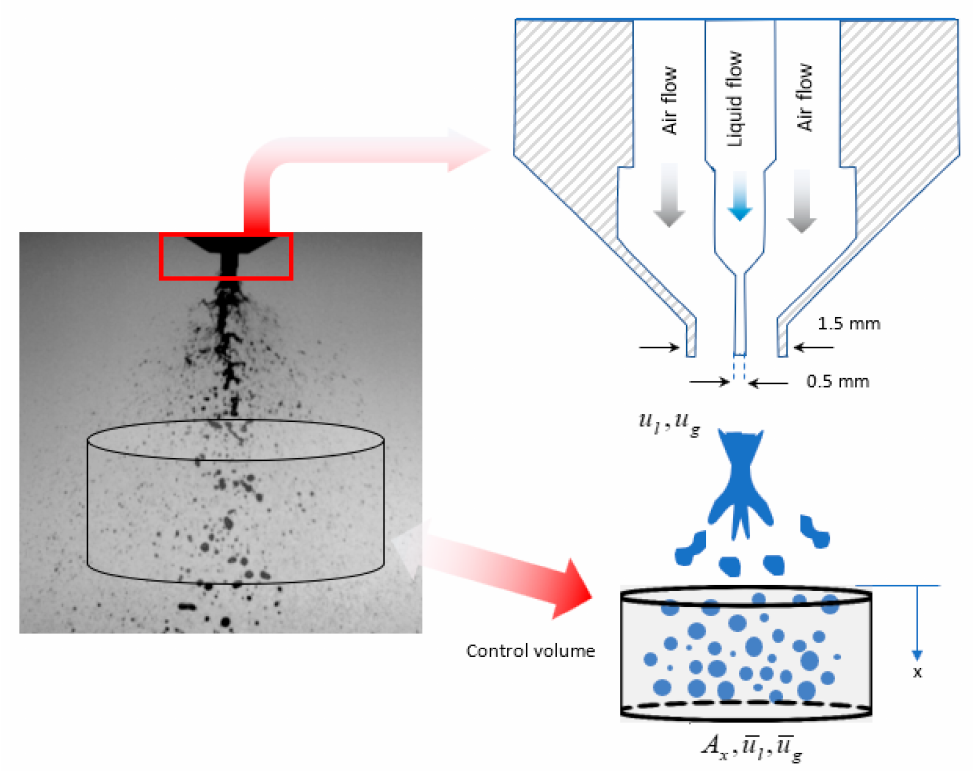
Figure 1. Left: near-field breakup process for two-fluid nozzle captured by high-speed imaging at a frame rate of 49 kHz [29]; right: spray configuration, and understudied control